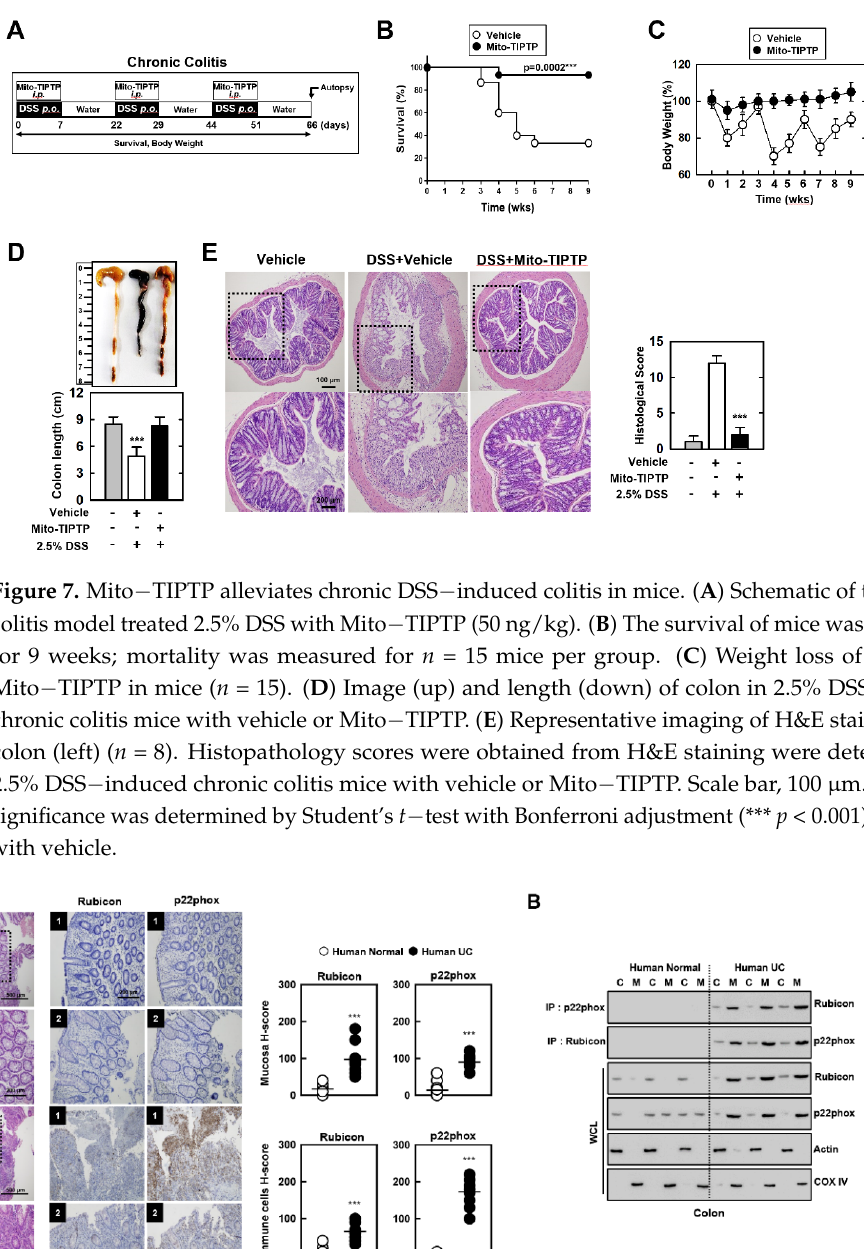
Figure 8. H&E staining and immunohistochemistry in colon in human normal and ulcerative colitis (UC) patients. ( A ) Human normal and UC patients were used for H&E staining and IHC with α p22phox and α Rubicon (left). H-score Rubicon and p22phox in mucosa and immune cells in colon were calculated by multiplying the percentage of the stained area by the staining intensity (right). Representative images from five independent healthy controls and patients are shown. Insets, enlargement of outlined areas. Biological replicates ( n = 10) for each condition were performed. ( B ) Colon of human normal and UC patients were cytoplasmic and mitochondria fractions separated and analyzed for Rubicon, subjected to IP with α Rubicon and α Rubicon. IB with α p22phox and α Rubicon. WCLs were used for IB with α Rubicon, α p22phox, α COX IV, and α Actin. Data from three of ten normal human and UC patients are shown. Statistical significance was determined by Student’s t -test with Bonferroni adjustment (*** p < 0.001) compared with human